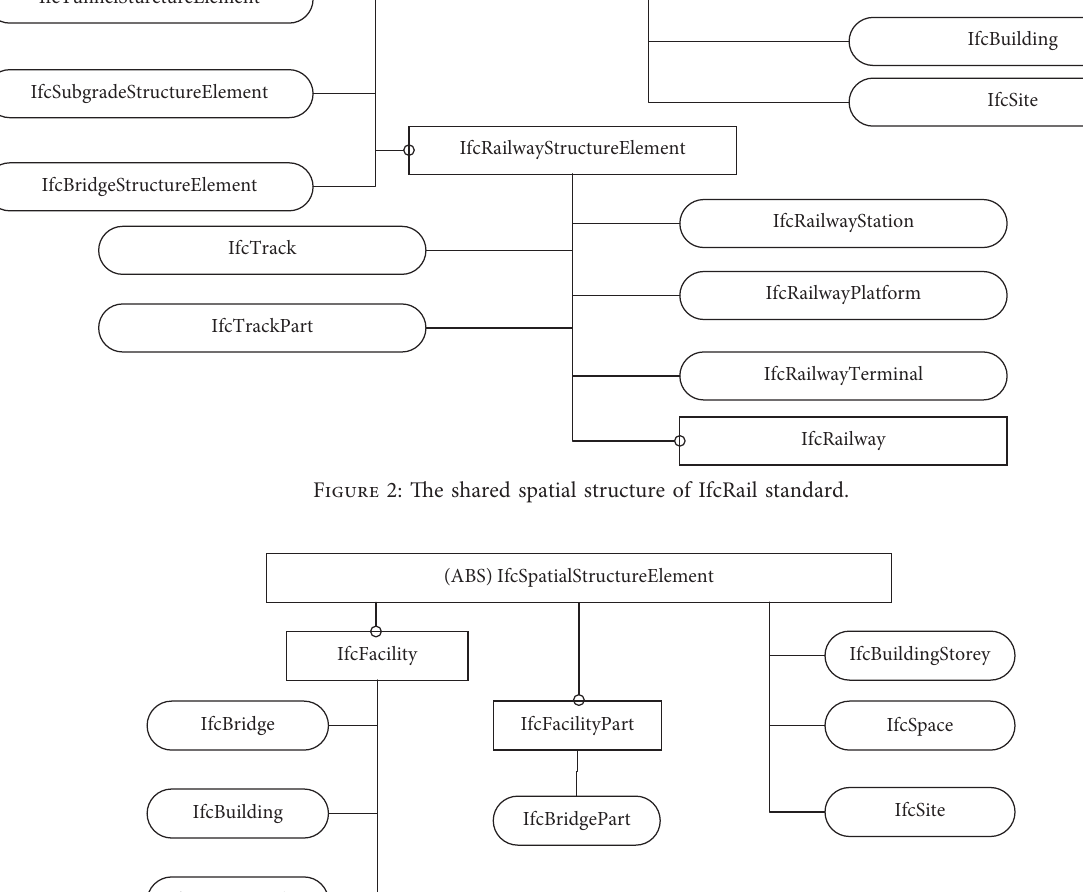
Figure 3: The spatial structure of the IFC4x3 standard.